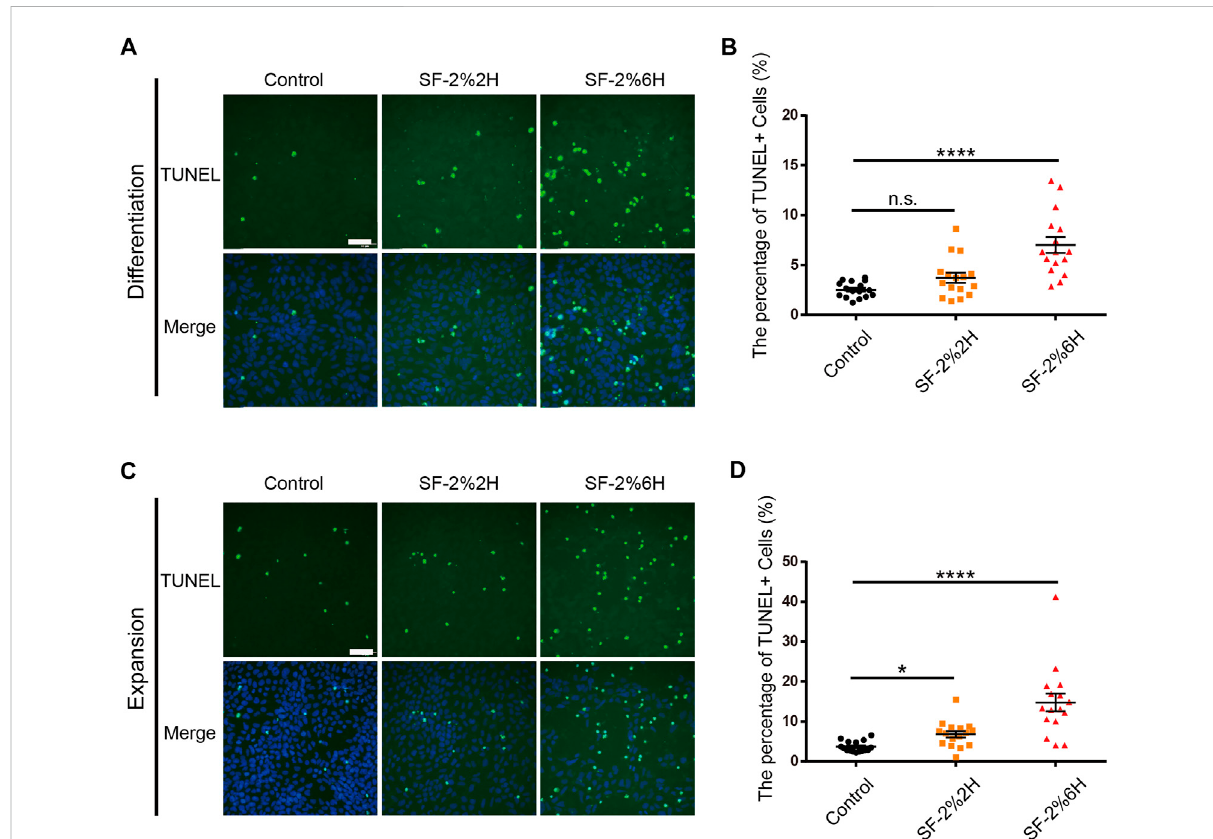
FIGURE 2 Sevo fl urane increased the apoptosis of monolayer hFPCs. (A – D) Representative image of TUNEL staining (green) with DAPI (blue) counterstain during both differentiation (A) and expansion (C) . (B) Quanti fi cation of (A) . (D) Quanti fi cation of (C) . Sample images of hFPCs were taken using an Olympus microscope IX83. Data represent mean ± SEM ( n =